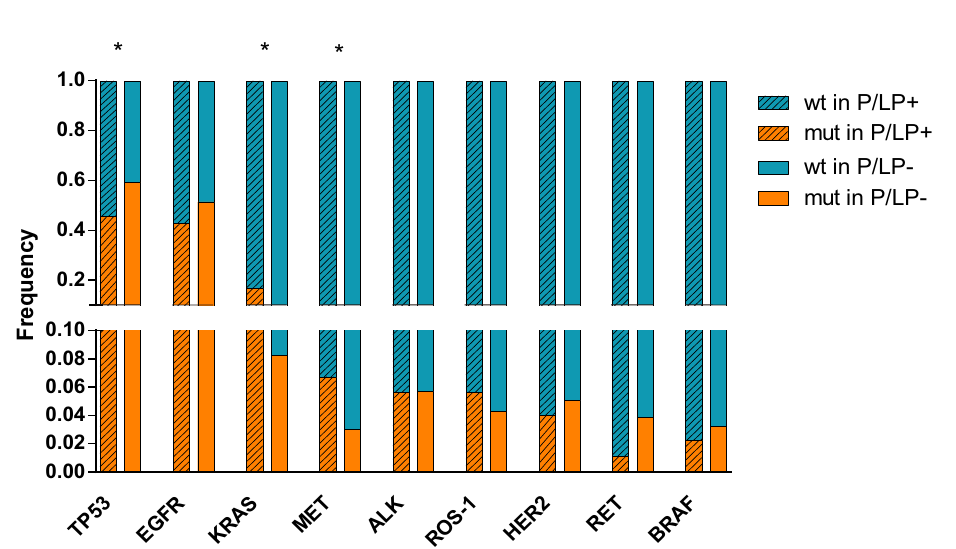
Fig. 4 Commonly somatic cancer gene mutations in lung cancer patients with and without germline variants. a Genomic landscape of somatic mutation in patients with P/LP germline mutation. Stacked plots (top) show the number of somatic mutations (SNV/indels, CNV and SV) in each tumor sample (column). The gender, histology subtype and clinical stage are shown on the bottom. Bar plot on the right shows the mutation frequency of each gene. b Normalized bar plot illustrates the frequency of nine commonly mutated genes. Stripped bars represent patients with P/LP germline variants. Open bars represent patients without pathogenic germline variants. *Statistic difference between two cohorts: TP53 , p = 0.016 . KRAS, p = 0.015 and MET , p = 0.027. P value is calculated with Chi-square test ( EGFR , TP53 , KRAS ) or Fisher ’ s exact test ( c-MET , ALK , ROS-1 , ERBB2 , RET , BRAF